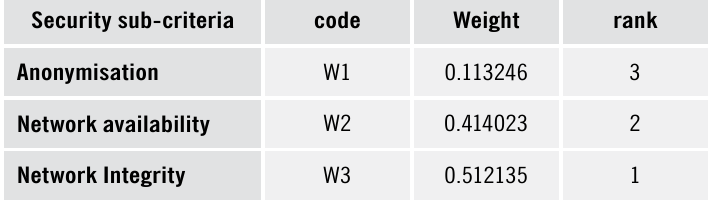
Table 10. Weight of security sub-criteria in the network (taken from the fuzzy nonlinear model) Security sub-criteria code Weight